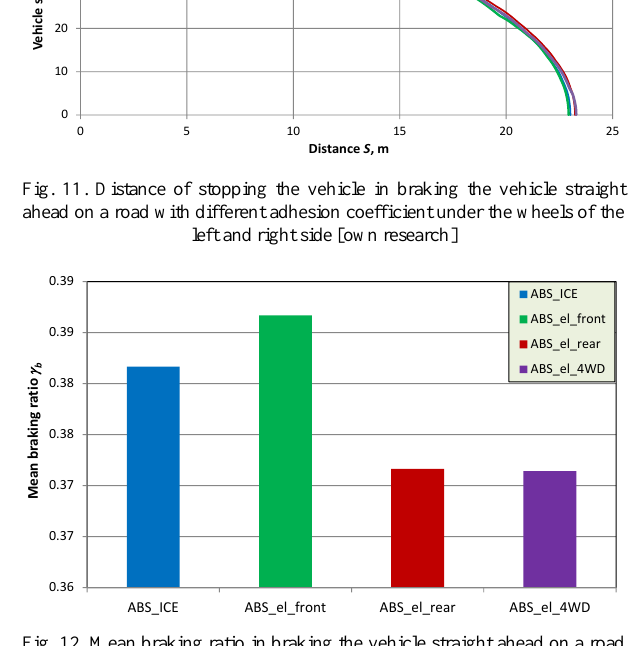
Fig. 12. Mean braking ratio in braking the vehicle straight ahead on a road with different adhesion coefficient under the wheels of the left and right side [own